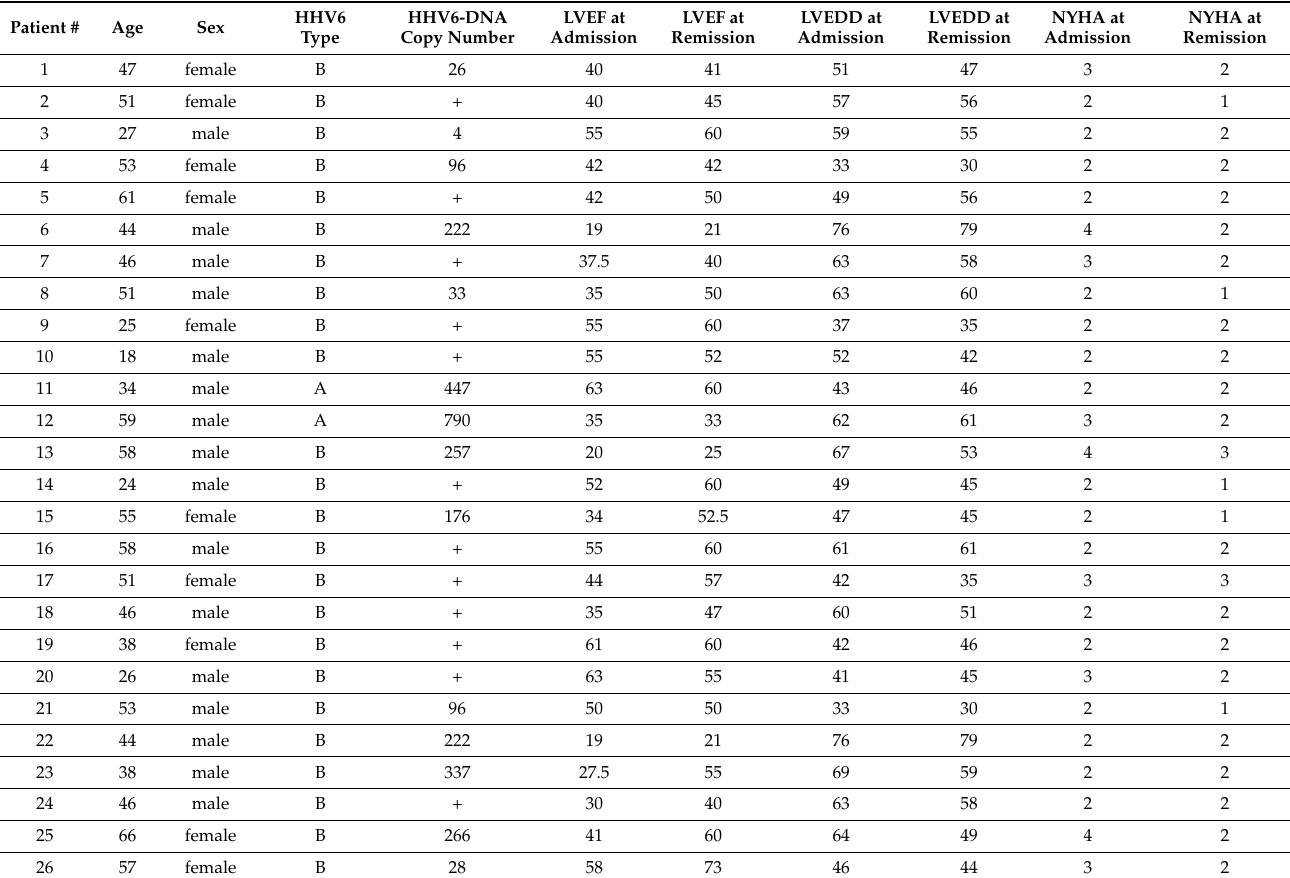
Table 1. Characteristics of the spontaneous cohort patients at admission and remission. Human herpes virus 6, HHV6; LVEDD, left ventricular end-diastolic diameter; LVEF, left ventricular ejection fraction; NYHA, New York Heart Failure Association functional